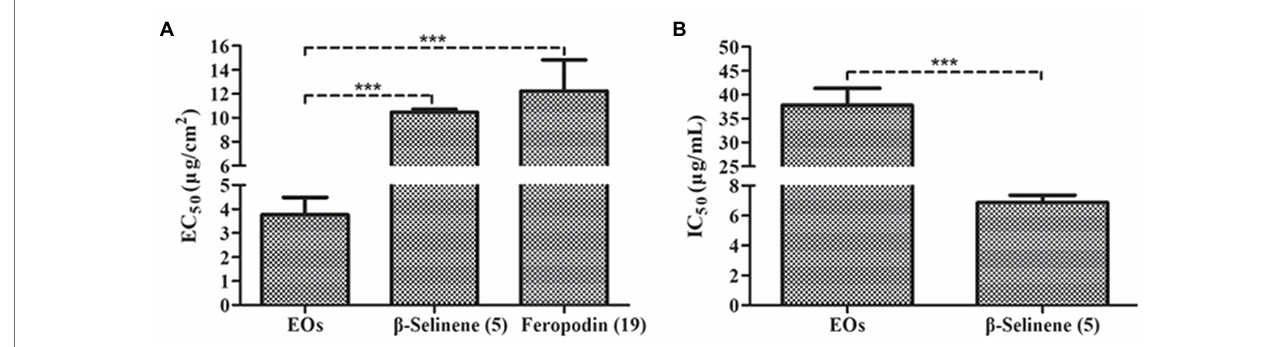
FIGURE 6 | (A) Antifeedant activity of A. nakaii EOs, β -selinene, and feropodin against S. litura. (B) Acetylcholinesterase inhibition activity of A. nakaii EOs and β -selinene. The mean differences were compared using t -tests. *** indicates that the value of p is less than